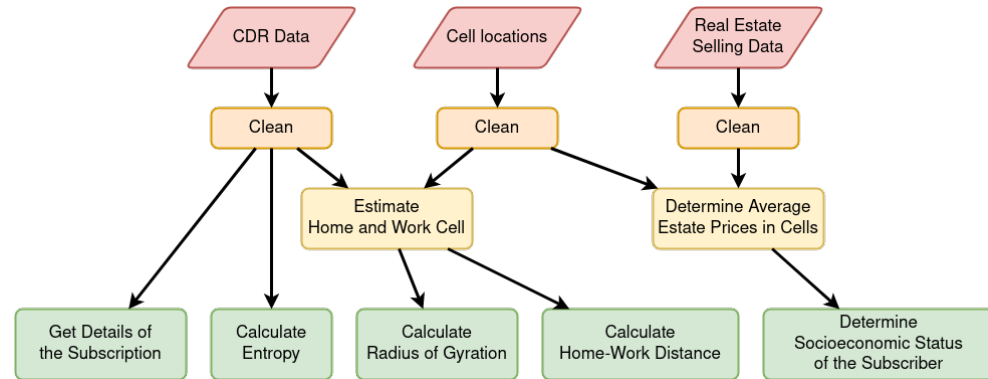
Figure 3. The simplified processing the Mobile Phone data along with the Cell information and the Estate Price data used to determine the financial status of the